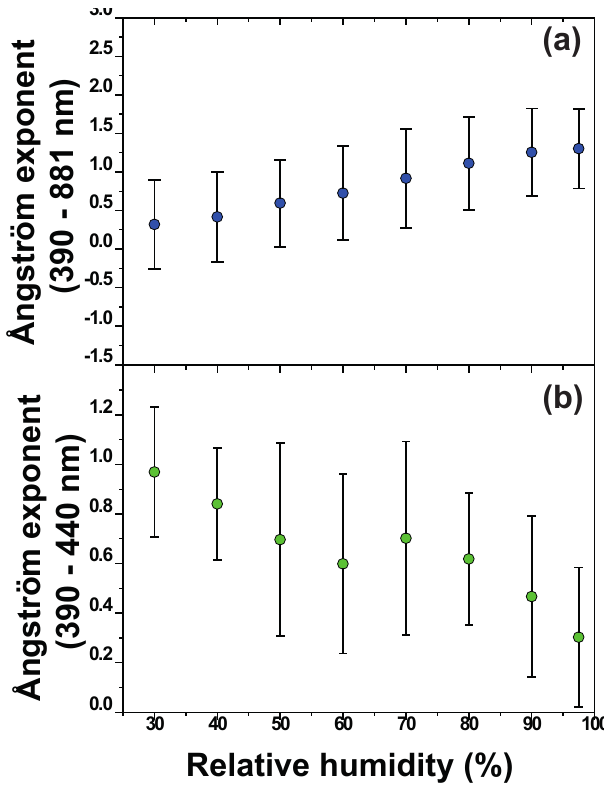
Figure 11. The 2009–2010 mean Ångström exponents and SD for the 380–881 (top) and 390–440nm (bottom) wavelength range for eight relative humidity classes.